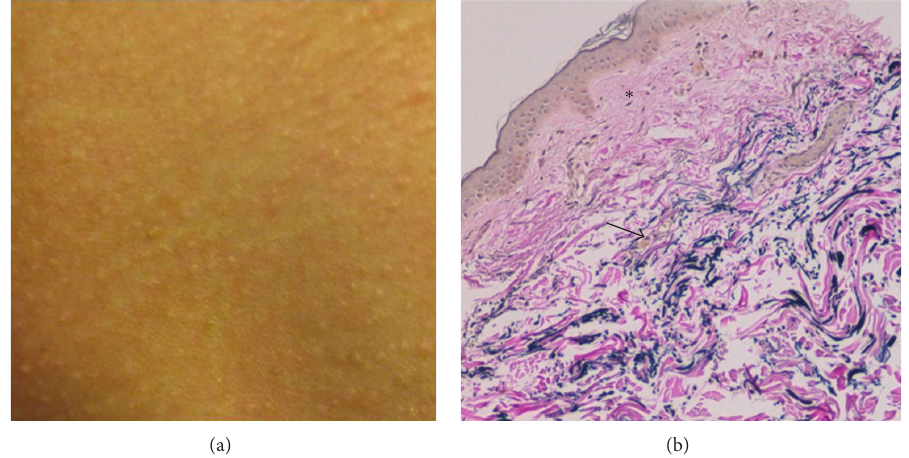
F 9: PXE-like papillary dermal elastolysis. �mall �esh-colored papules can be seen in the neck region (a). L� examination reveals loss of elastic �bers in the papillary dermis and abnormal pattern in the reticular dermis (b,